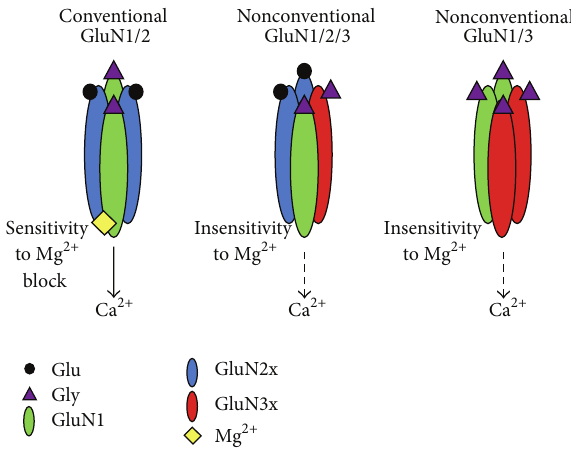
Figure 1: Schematic illustrating the conventional NMDAR con- taining GluN1 and GluN2 subunits (left), a nonconventional het- erotrimeric NMDAR containing all three subunits (middle), and a glycine diheteromeric NMDAR containing GluN1 and GluN3 subunits (right). The main properties that are changed in these nonconventional NMDAR are the agonist binding, the insensitivity to Mg 2+ , and the low permeability to Ca 2+ . Thus GluN3-containing NMDAR exert a dominant-negative effect on NMDAR